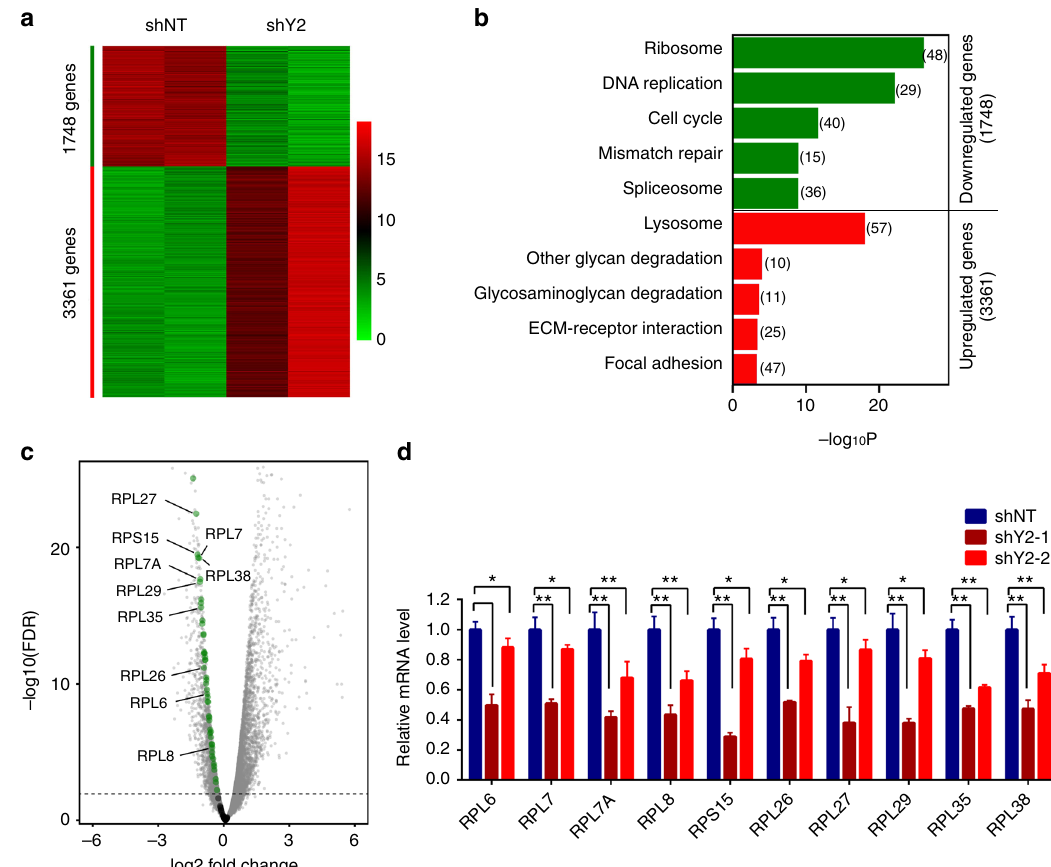
Fig. 2 YEATS2 is required for the expression of ribosome protein-encoding genes. a Heatmap representation of differentially expressed genes in control (shNT) and YEATS2 knockdown (shY2) cells from two independent biological replicates of RNA-seq experiments. Fisher ’ s exact test was used to de fi ne differentially expressed genes ( q < 0.01). The color key represents normalized Log2 expression values. b Kyoto Encyclopedia of Genes and Genomes pathway analysis of downregulated (green) or upregulated (red) genes in YEATS2 knockdown cells compared with control cells. The numbers of genes within each functional group are shown in parenthesis. Fisher ’ s exact test was used to identify the biological function with signi fi cant p- values (Benjamini – Hochberg corrected p < 0.05). c Volcano plot of differentially expressed genes in YEATS2 knockdown cells compared with control cells. 49 downregulated ribosomal protein genes are shown in green and 30 non-differentially expressed ribosomal protein genes in black. FDR, false discovery rate. d Quantitative RT-PCR (qRT-PCR) analysis of the expression of ten randomly picked ribosomal protein genes in control (shNT) and YEATS2 knockdown (shY2) cells. Error bars indicate S.E.M. of three biological replicates. * p < 0.05; ** p < 0.01 (Student ’ s t